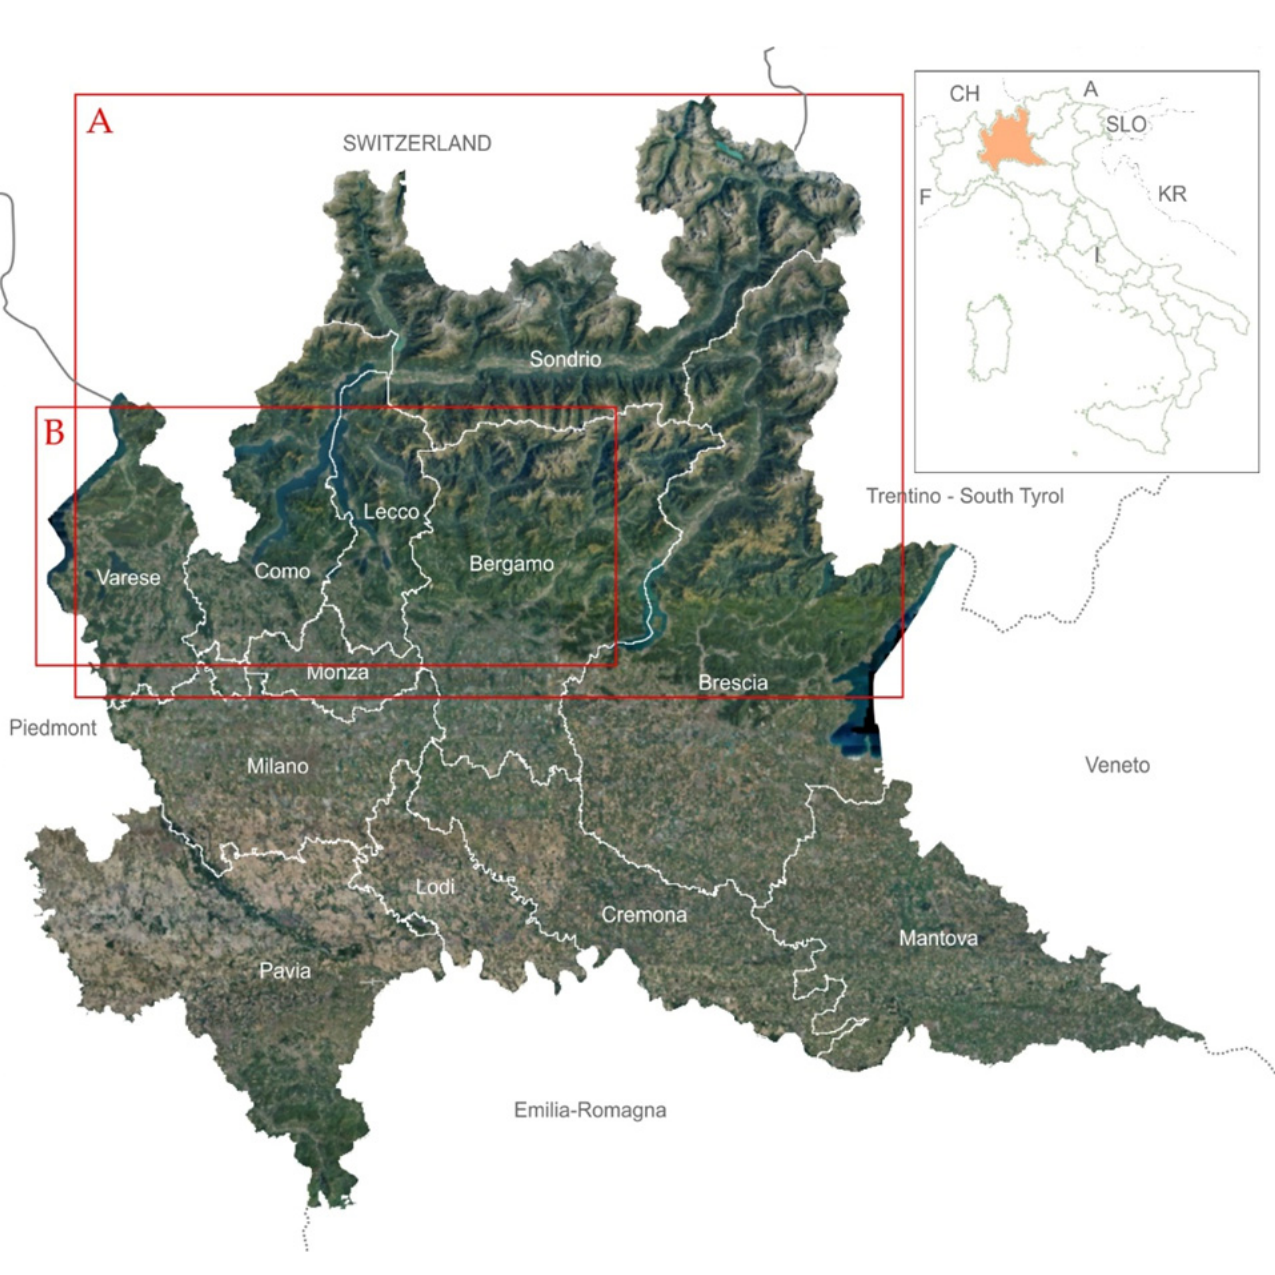
Figure 1. Location of the study area: the ( A ) alpine and ( B ) pre-alpine district of the Lombardy region, with indications of administrative provinces: Varese (VA), Como (CO), Lecco (LC), Bergamo (BG), Sondrio (SO), and Brescia (BS).